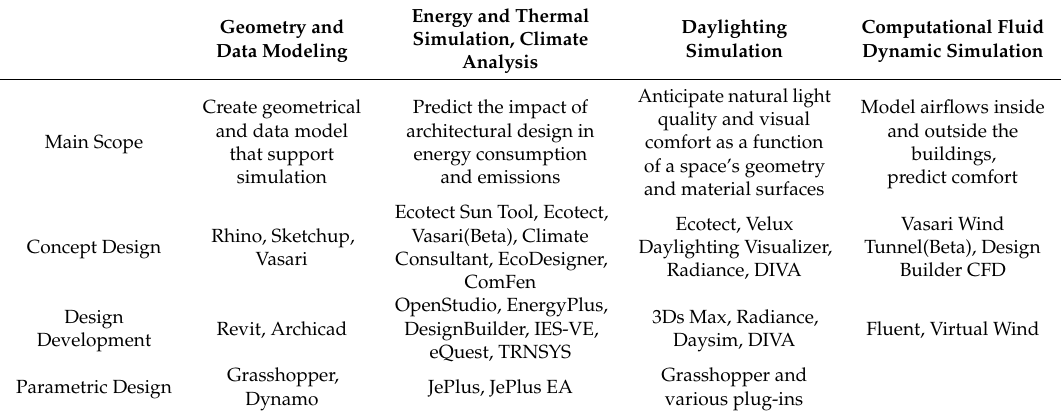
Table 1. A Survey Parametric Tools in the Architecture Industry and their